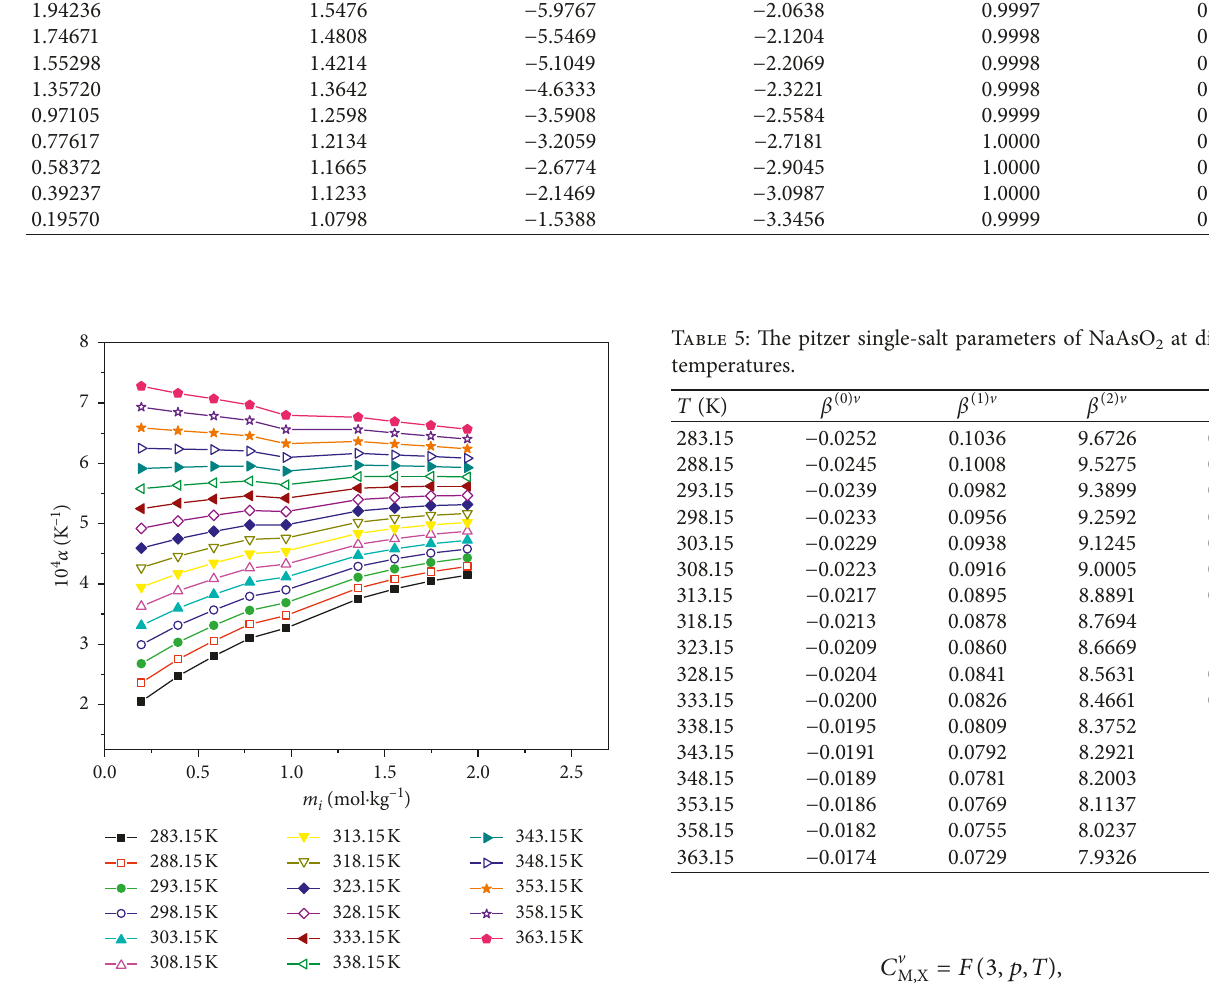
Figure 2: Thermal expansion coefficient ( α ) of NaAsO the molality ( m ) at different temperatures.